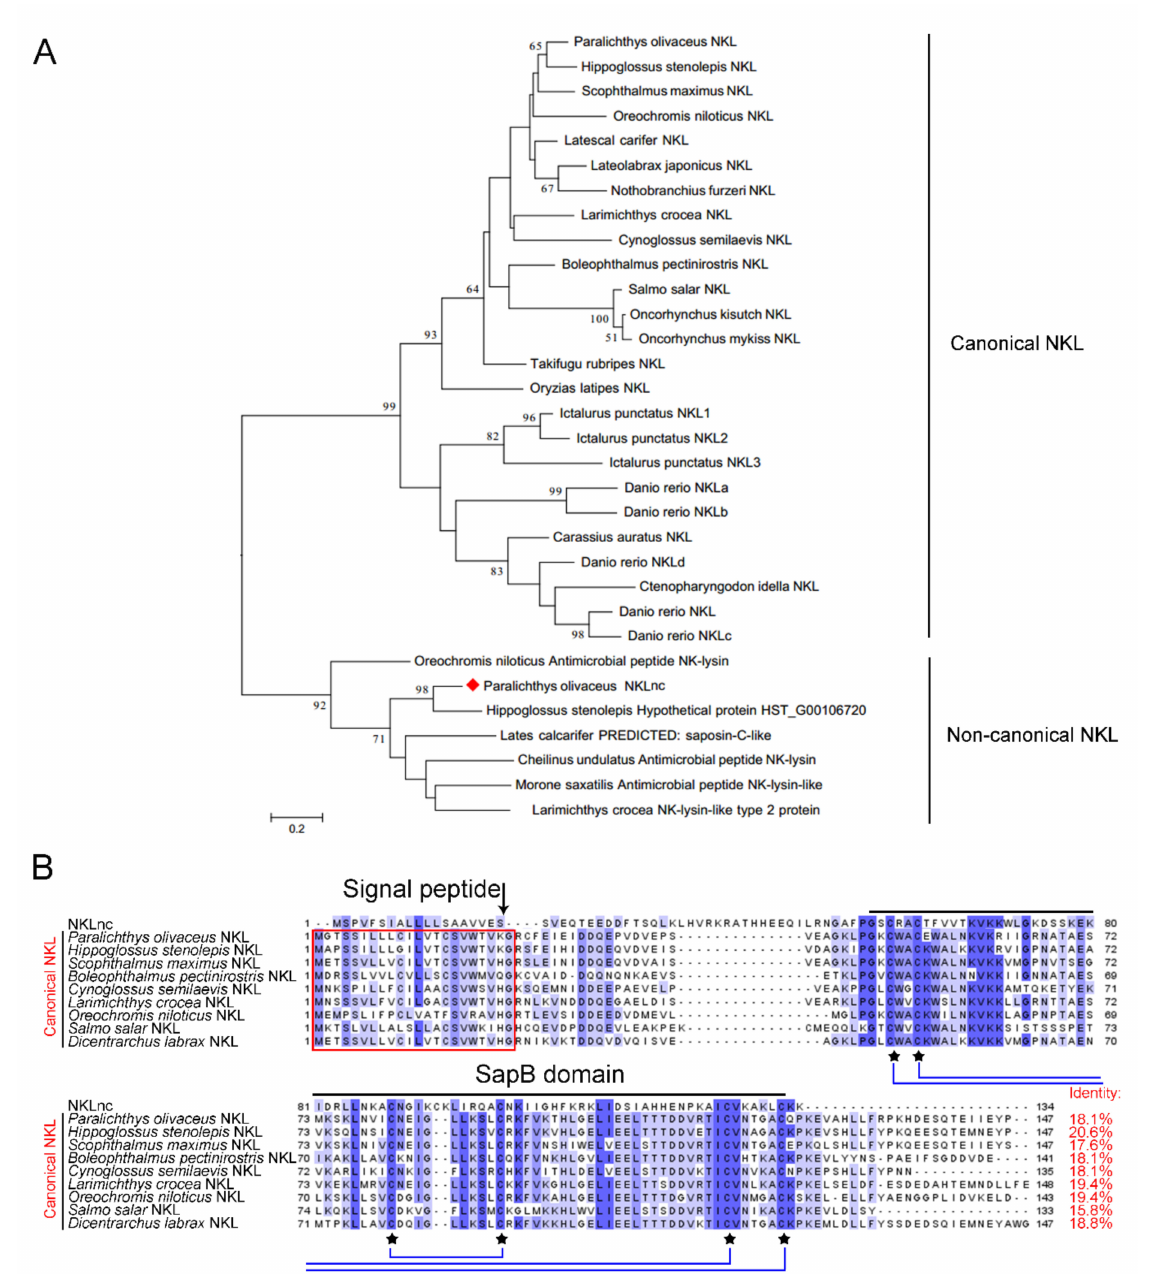
Figure 1. Phylogenetic and sequence analyses of NKLnc. ( A ) Phylogenetic analysis of NKLnc. The values at the forks indicate the percentage of trees in which this grouping occurred after bootstrapping (1000 replicates; shown only when the values were >50%). Scale bar, the number of substitutions per base. ( B ) Sequence alignment of fish NKL homologues. The residues that are >50% identical are shaded, with identical residues shaded in dark blue. The alignment gaps are indicated with “-”. The predicted cleavage site for the signal peptide is indicated with “ ↓ ”. The conserved six cysteine residues are marked with “ (cid:70) ”. The cysteine residues that form a disulfide bond are linked by a blue